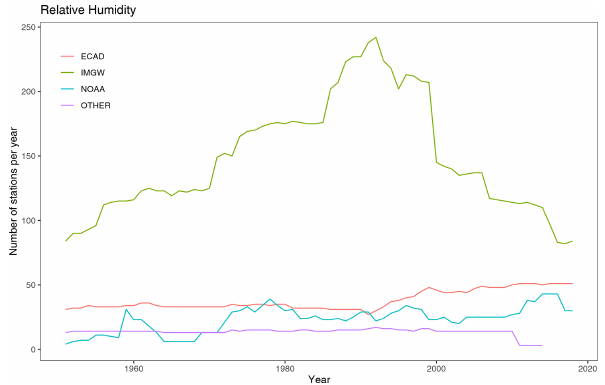
Figure 4. Number of meteorological stations for relative humidity observations per year from 1951 to 2019.